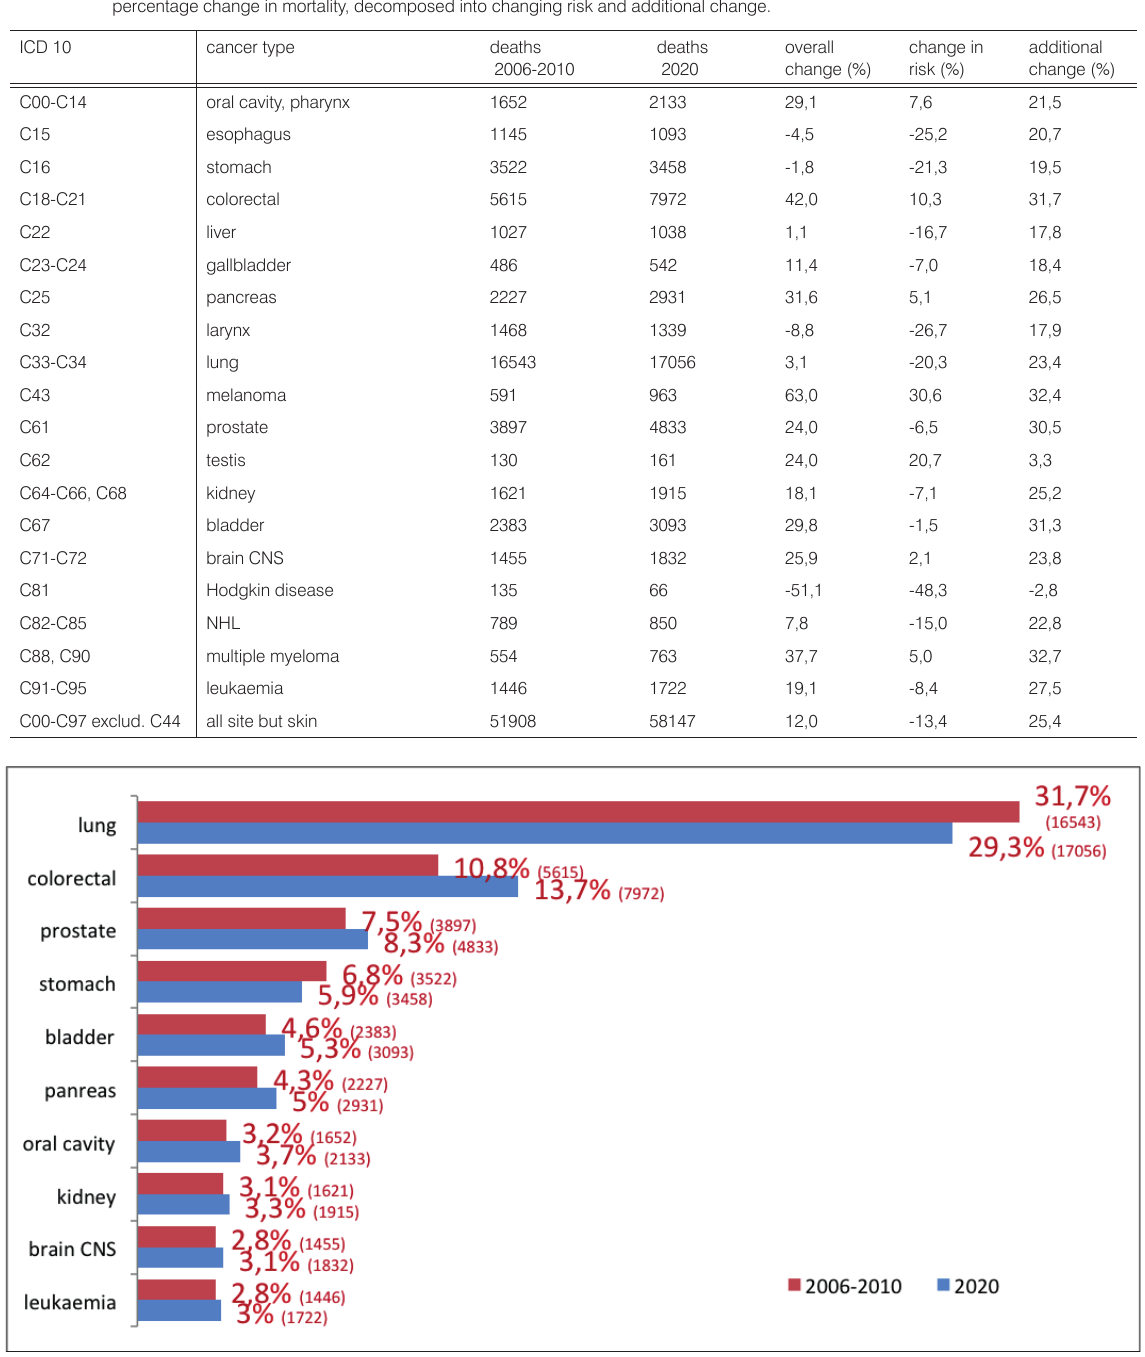
Figure 3 . The structure of cancer mortality in males in Poland, 2006-2010 and 2020